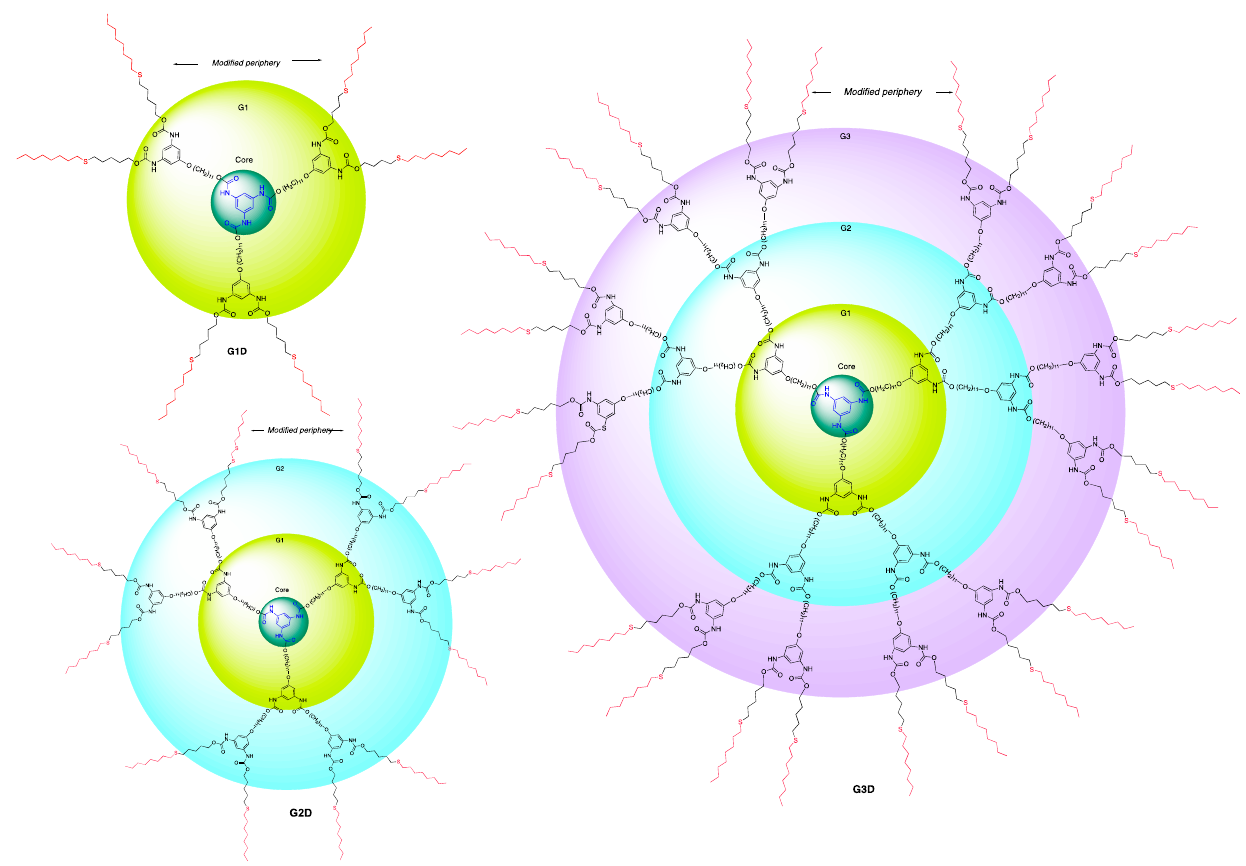
Figure 2. Structure of synthesized G1, G2, and G3 dendrimers showing modified periphery.